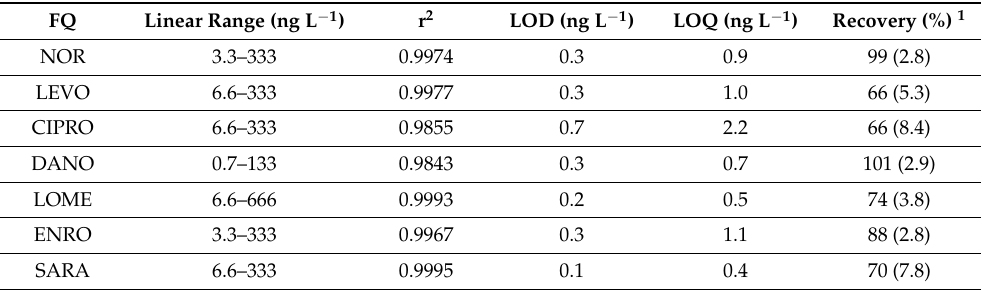
Table 3. Analytical characteristics of the online MISPE